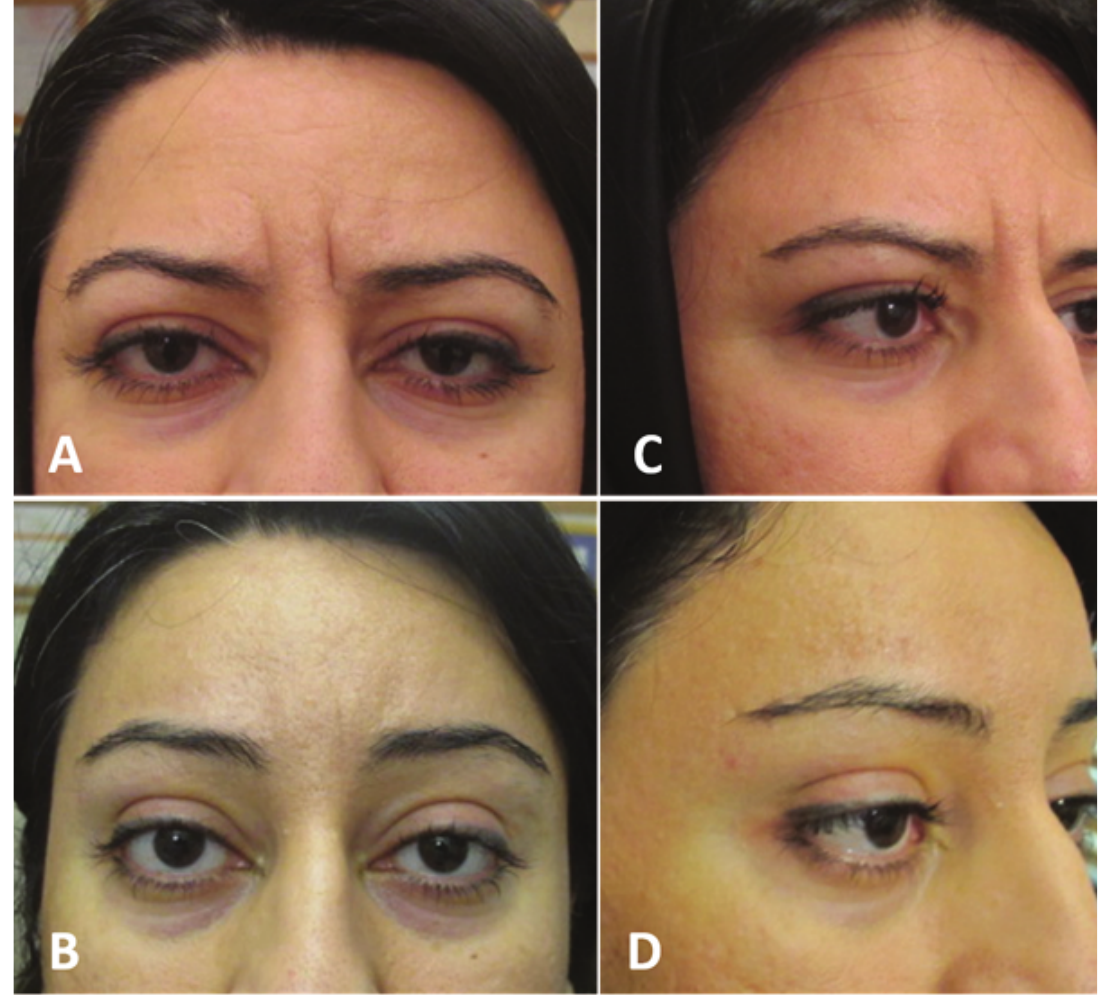
Figure 13. A patient with deep static glabellar lines (A & C) who underwent endoscopic forehead lift with glabellar smoothening and resulted in total eyebrow lift and no glabellar lines (B & D) one year after the